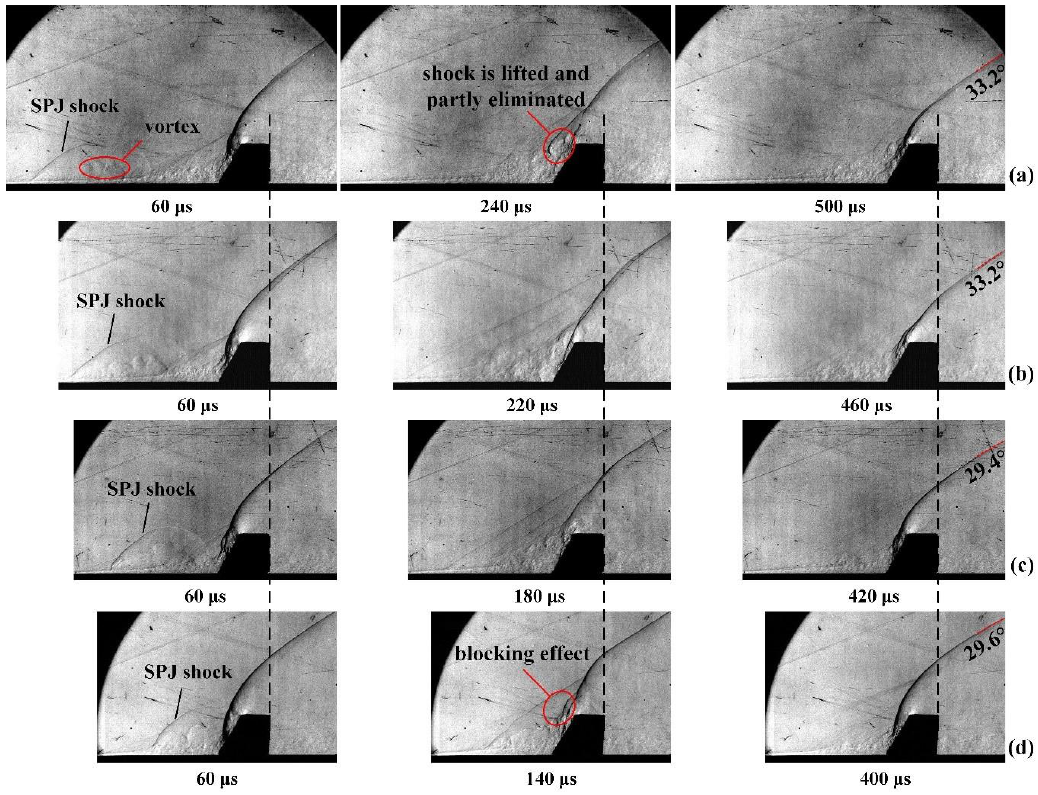
Figure 11. Comparison of the flow field evolution process when SPJ exit is outside the separation zone at different ramp distances: ( a ) case10—90 mm, ( b ) case9—70 mm, ( c ) case1—50 mm, ( d ) case8—30 mm.